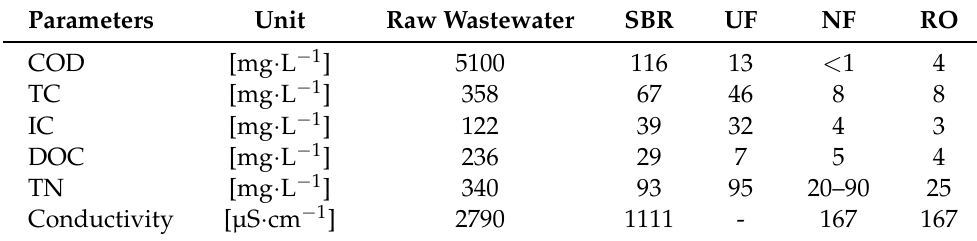
Table 7. Characterization of treatment process investigated by Racar et al. [56].